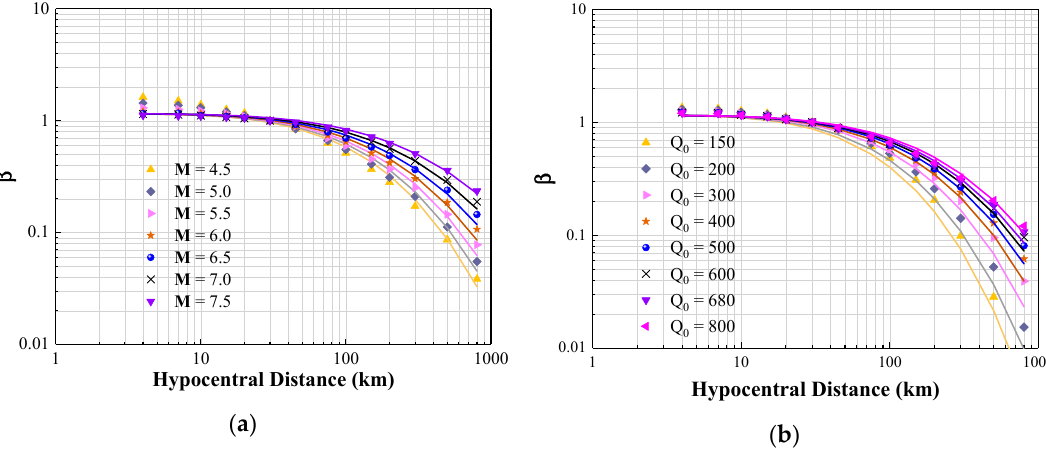
Figure 5. Anelastic attenuation factor ( β ). ( a ) Simulated PGV values normalised at Q 0 = 680 for varying M values (M4.5–M7.5) and distances (4–800 km) shown alongside predictions by CAM (lines); ( b ) simulated PGV values normalised at M = 6 for varying Q 0 values (150–800) and distances (4–800 km) shown alongside predictions by CAM (lines).